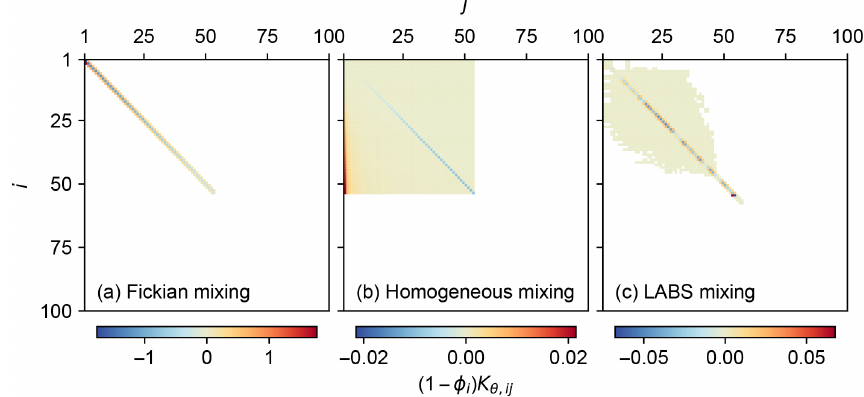
Figure 1. Transition matrices corrected for porosity, representing three different bio-mixing styles: (a) Fickian intraphase biodiffusion, (b) homogeneous mixing and (c) automaton-based mixing by a particle-tracking bioturbation simulator